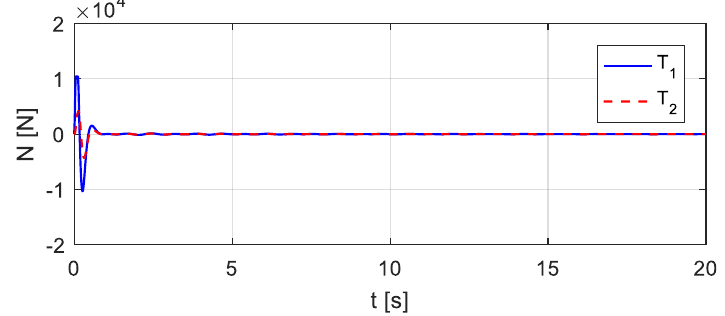
Figure 23. Estimated time histories of the excitations at wheel T 1 and T 2 in case wheel T 2 bumps.